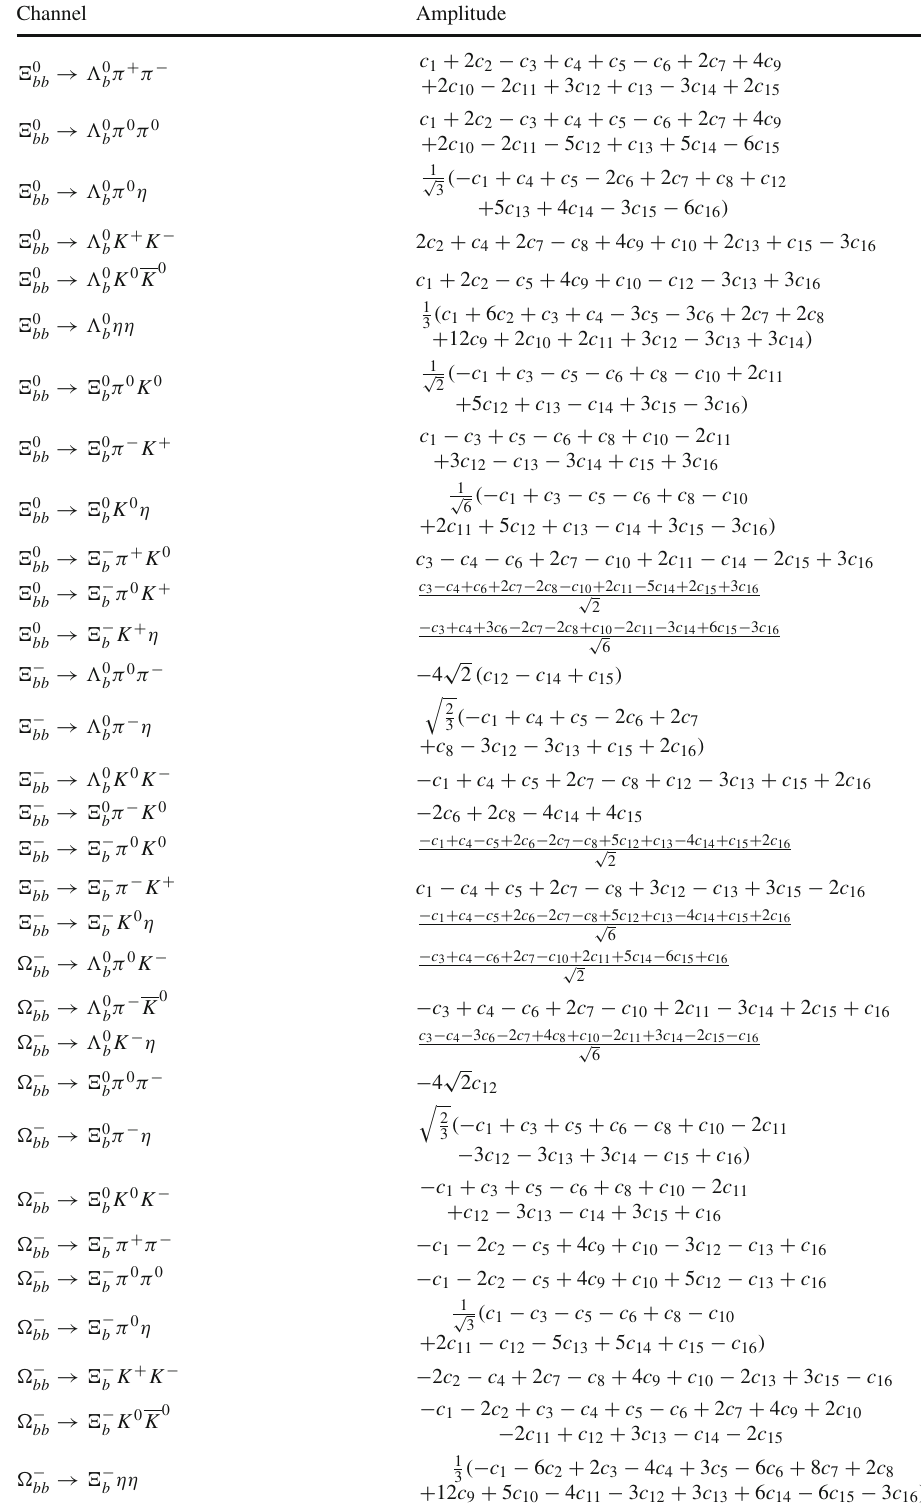
Table 22 Doubly bottom baryon decays into a bqq (anti-triplet) induced by the charmless b → d transition and two light